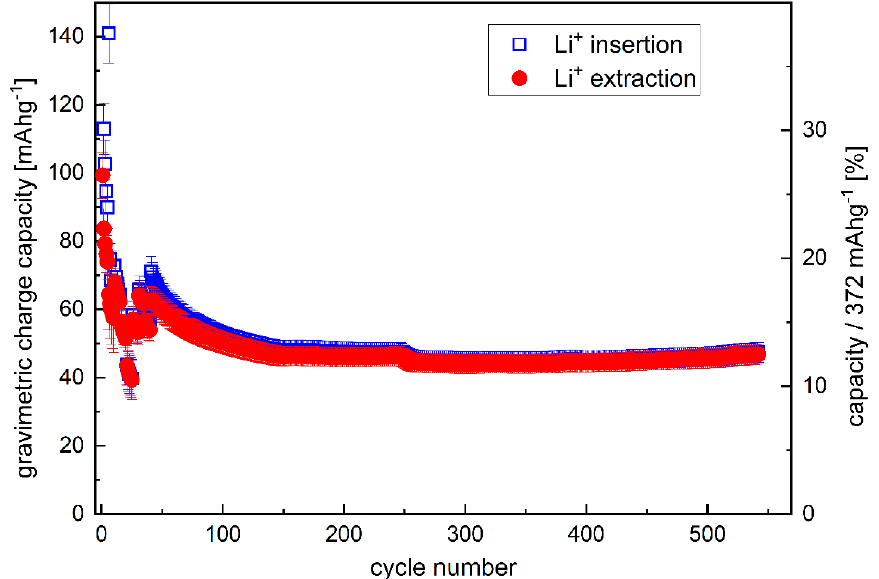
Figure 5. Variation of the gravimetric capacity of the C/Cu ML with cycle number. A color version of this figure can be viewed online.